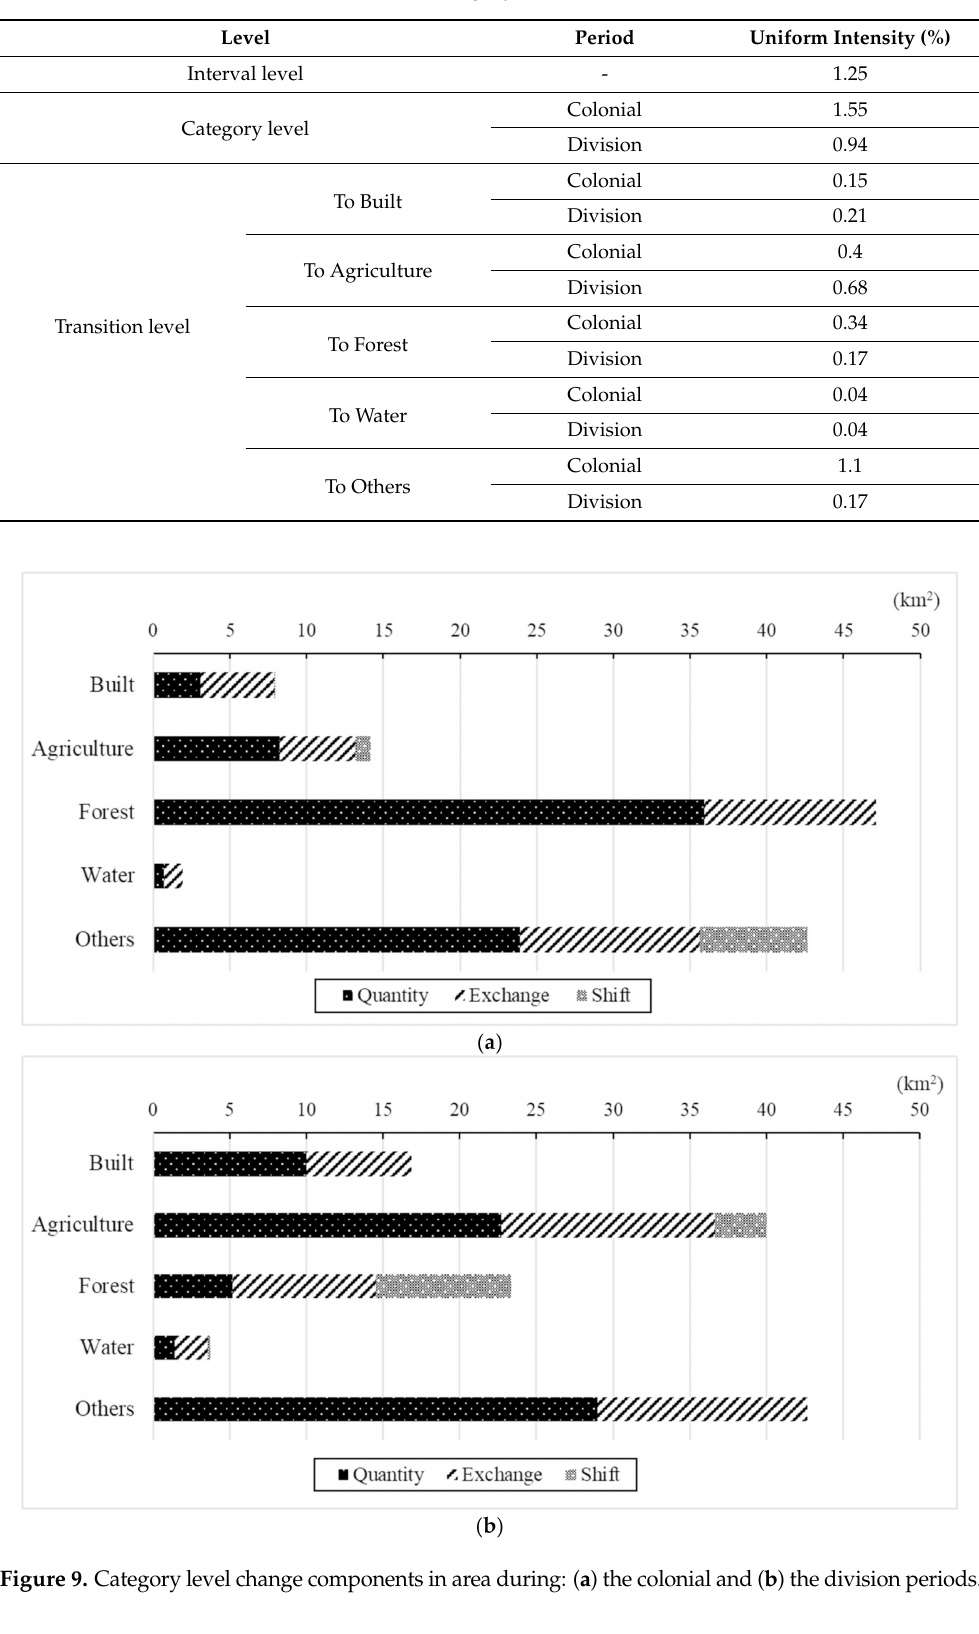
Table 2. Uniform intensities at the interval, category, and transition levels.